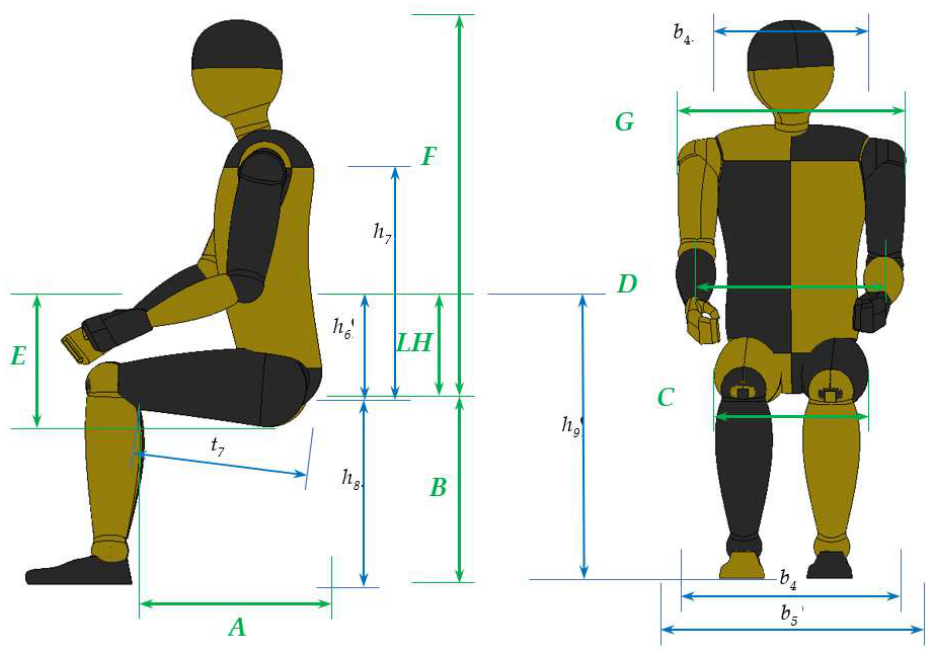
Figure 3. The functional dimensions of a chair and the anthropometric measurements.